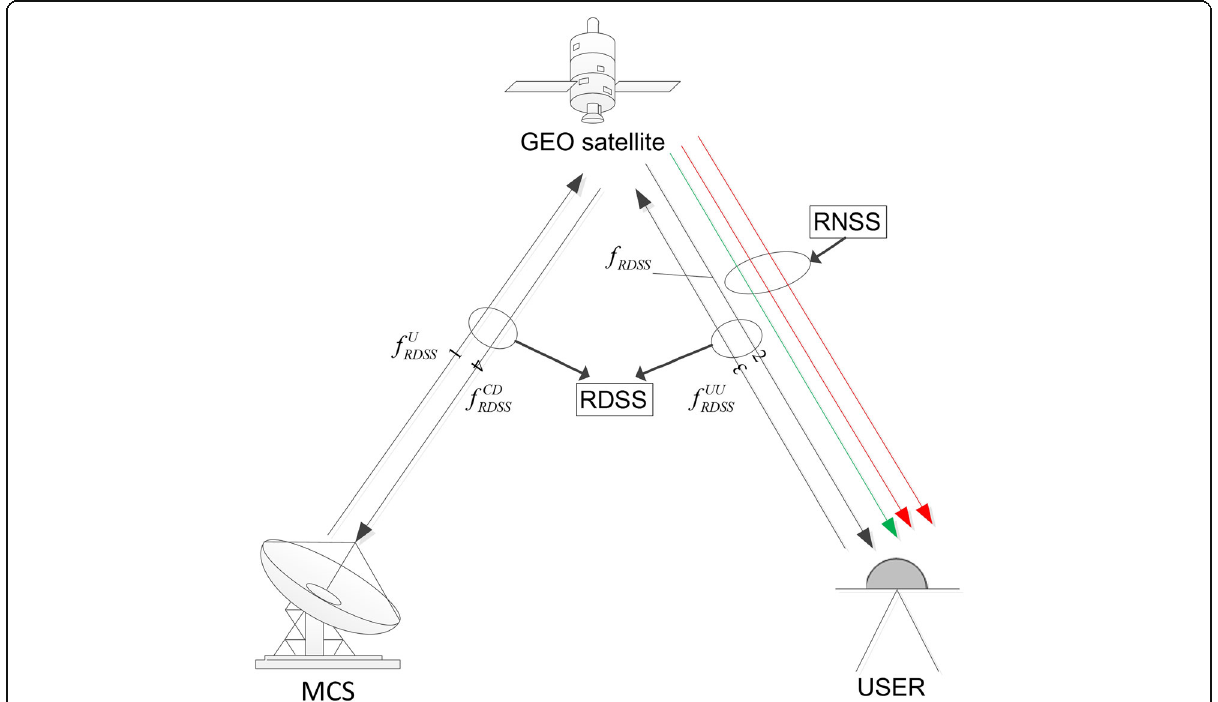
Fig. 1 Schematic diagram of BeiDou ’ s RDSS and